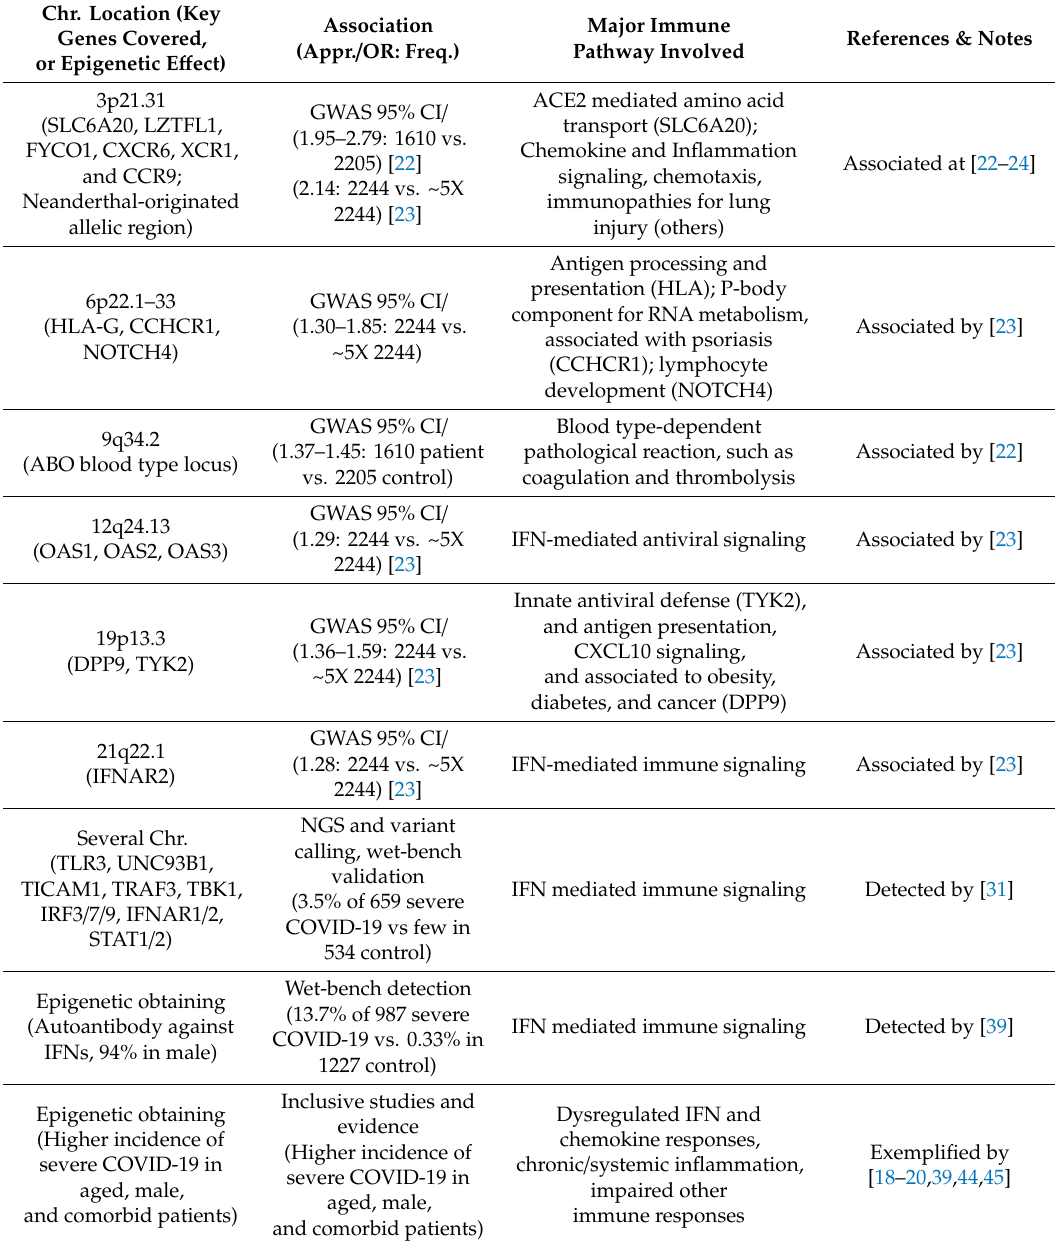
Table 1. Genetic inborn or epigenetic obtaining errors associated with severe COVID-19